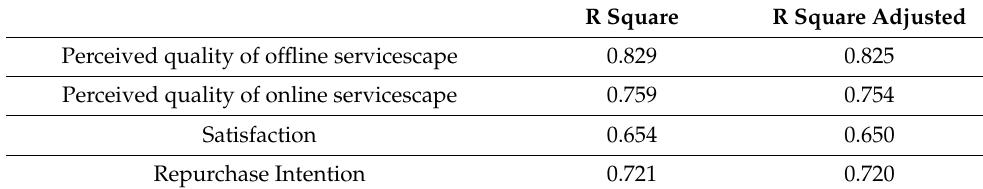
Table 7. Inner Model Evaluation